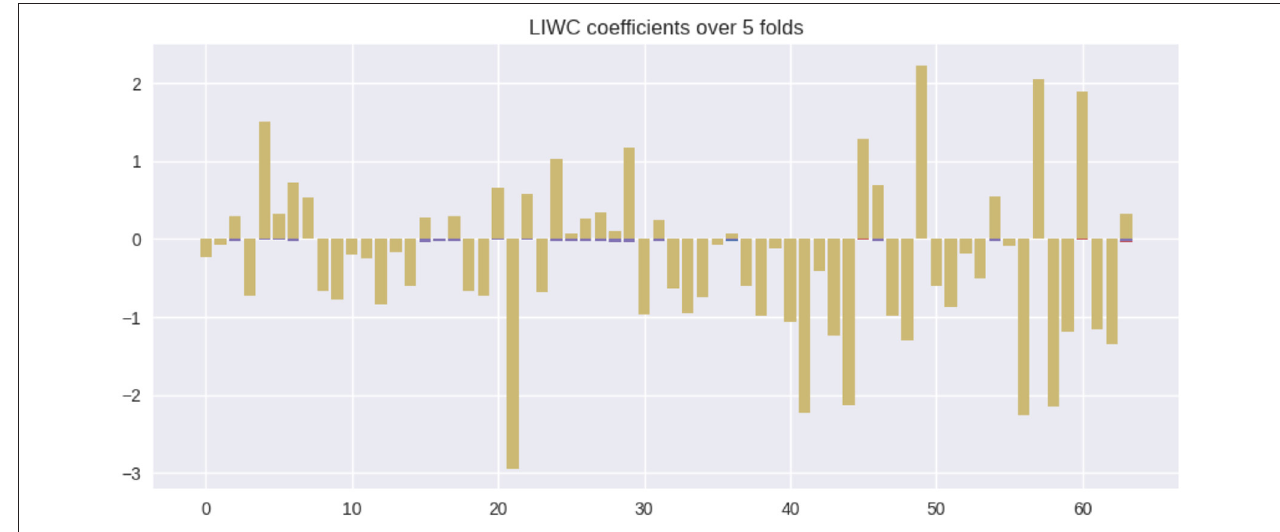
FIGURE 2 | Feature coefficients β across various train-test splits. Colors: yellow = overlapping feature weights, purple = non overlapping feature weights.